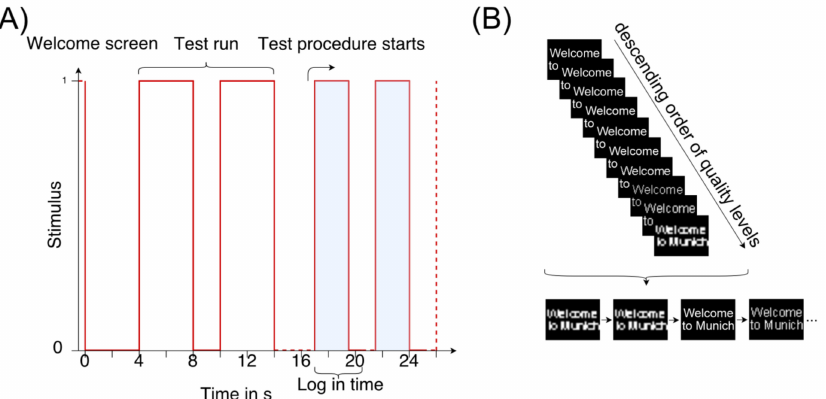
Figure 3. Schematic illustration of the testing procedure and used data set in both studies. ( A ) Visual- ization of the testing procedure including the welcoming screen, test run phase and the test procedure phase. The stimulus illustrates a projection appearing on the projection area. In addition, the log-in time is displayed with shading in the test procedure. ( B ) Display of all ten different quality levels of the displayed pictures in descending order of quality. Additionally, an example of the possible test procedure output is displayed after applying the randomization algorithm to the data set of 30 images (10 qualities × 3 repetitions) in the lower part of ( B